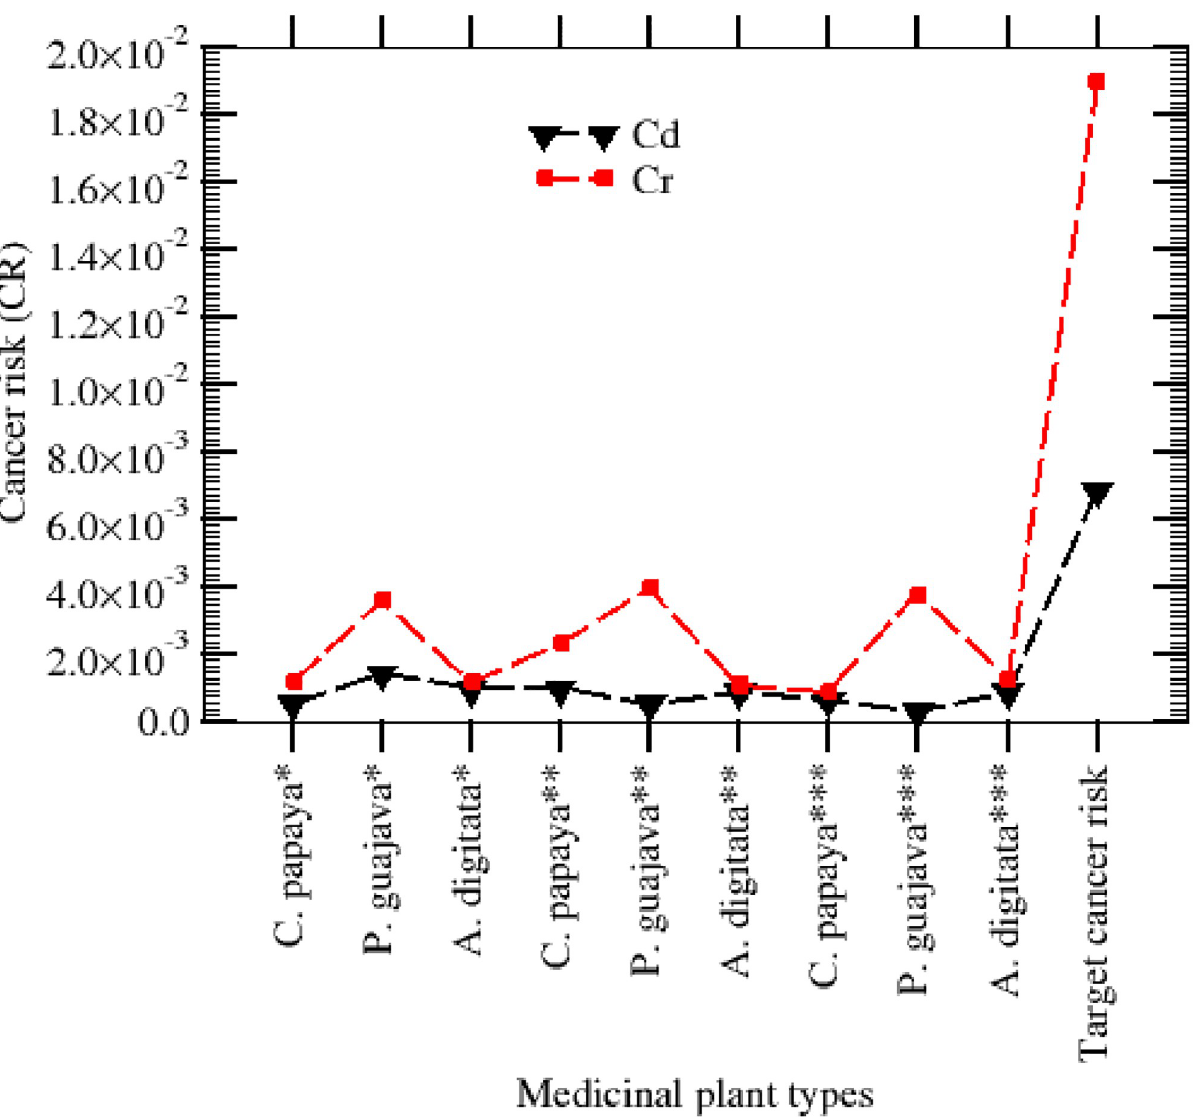
Fig 4. The cancer risk and target cancer risk in ingesting these polluted herb